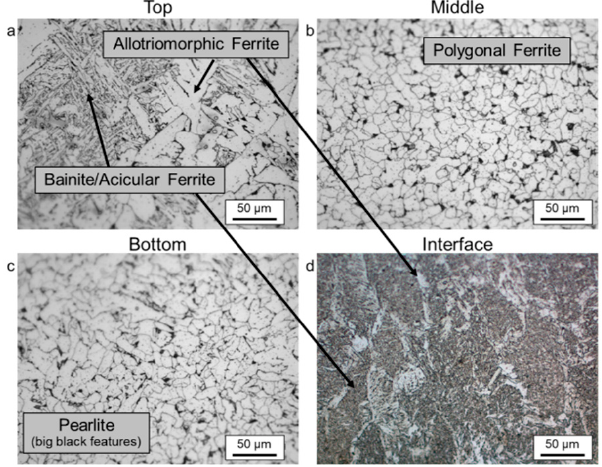
Figure 9. Microstructure from different locations in the build height. ( a ) The last layer, top. ( b ) The middle of the build. ( c ) Bottom of the build. ( d ) Interface between base plate and beginning of the build.